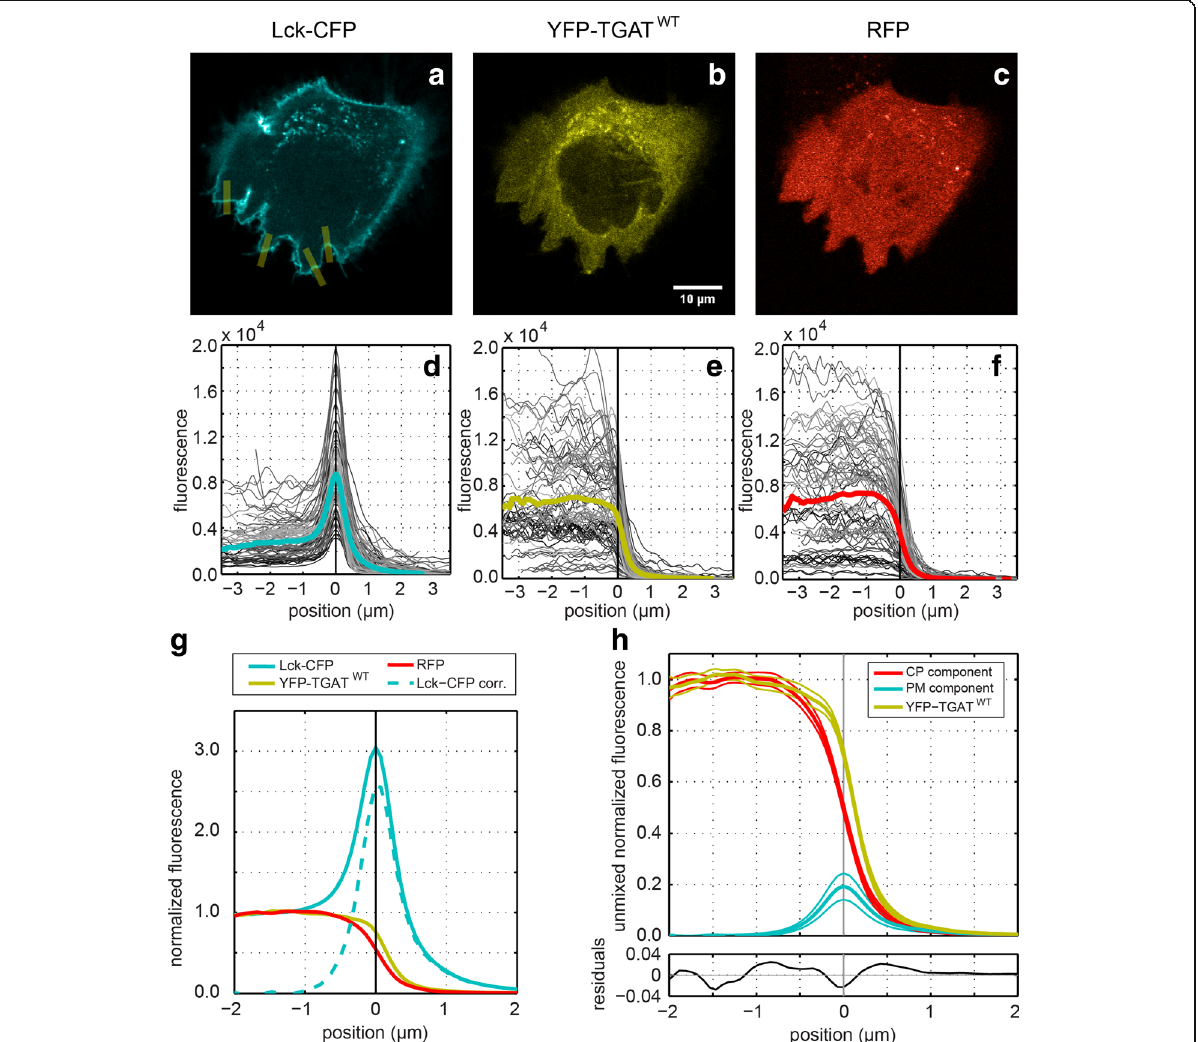
Fig. 2 Quantification method for plasma membrane localization. High resolution confocal images (1024 × 1024 px with a pixel size of 140 nm) were taken of HeLa cells transfected with: ( a ) a plasma membrane marker Lck fused to CFP, ( b ) a protein of interest fused to YFP (wild type TGAT in this example) and ( c ) a cytoplasmic marker using a soluble RFP. The CFP channel was registered to the YFP channel based on the spatial shift determined with the positive control. The RFP channel was registered to the YFP channel based on the spatial shift determined with the negative control. Background fluorescence was subtracted from each image prior to processing. Using ImageJ many lines (10 px wide and 6 – 10 μ m long) were carefully drawn perpendicular to the plasma membrane in regions with a well-defined cytoplasm-plasma membrane-extracellular space transition (yellow lines in panel a ). For each channel line-scans were performed with the same lines using linear interpolation, the profiles were aligned and centered based on the peak in the Lck-CFP channel and placed on the same axis (panel d ). The other channels were aligned and centered using the same positional shift and axis (panels e and f ). Subsequently the average profiles were calculated (colored lines in panels d - g ), and normalized to unity with respect to the cytoplasm fluorescence level (panel g ). Because the Lck-CFP marker is also localized in the cytoplasm, the profile was corrected by subtracting the normalized RFP profile (dashed line panel g ). In order to extract the cytoplasmic (CP) and plasma membrane (PM) component, the YFP profile was unmixed using the normalized RFP profile and the corrected Lck-CFP profile (panel h ). The 95% confidence intervals (thin solid lines above and below the profiles) were estimated using bootstrapping (See material and Methods for